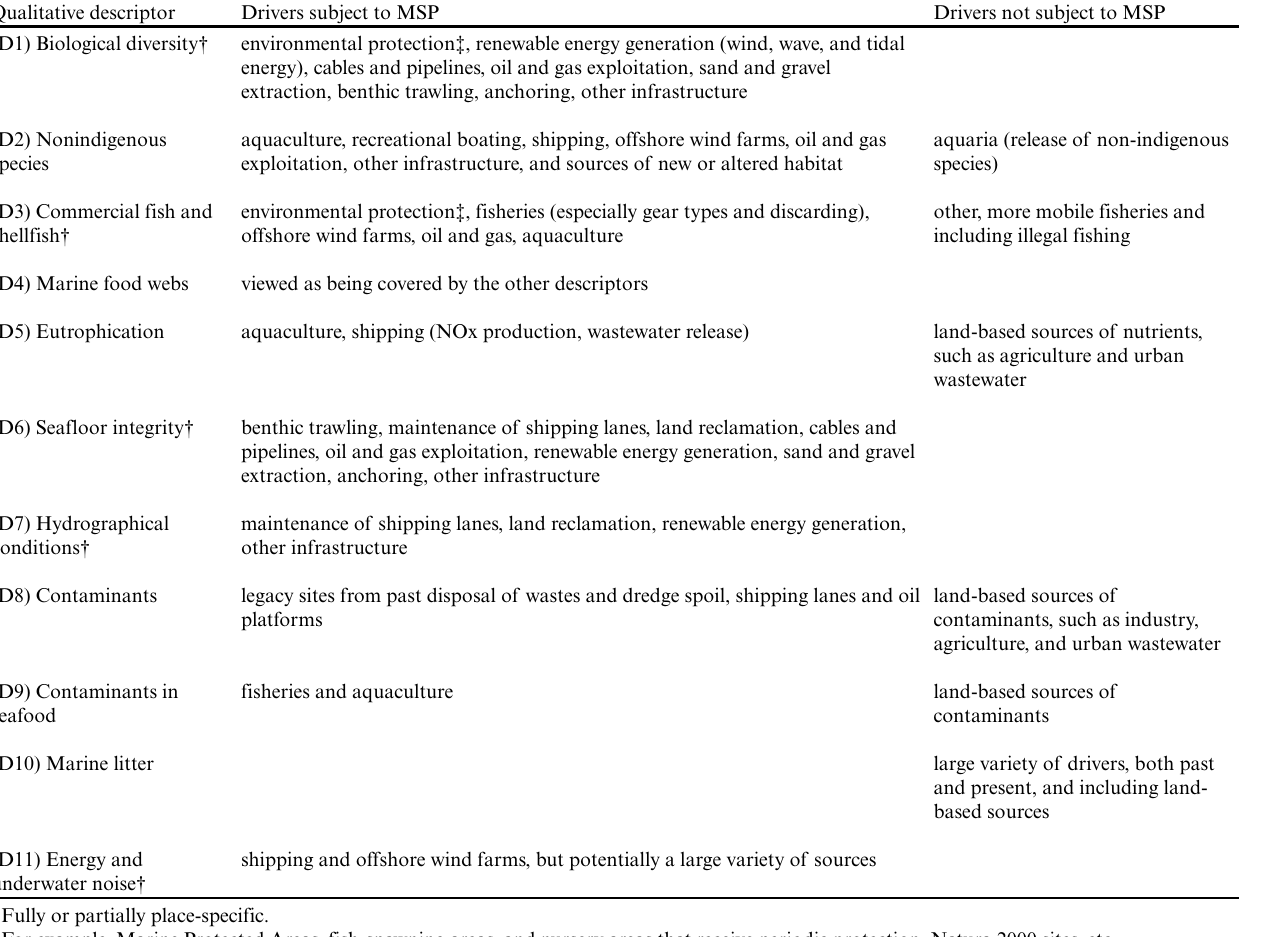
Table 2 . Spatial planning characteristics of Marine Strategy Framework Directive (MSFD)